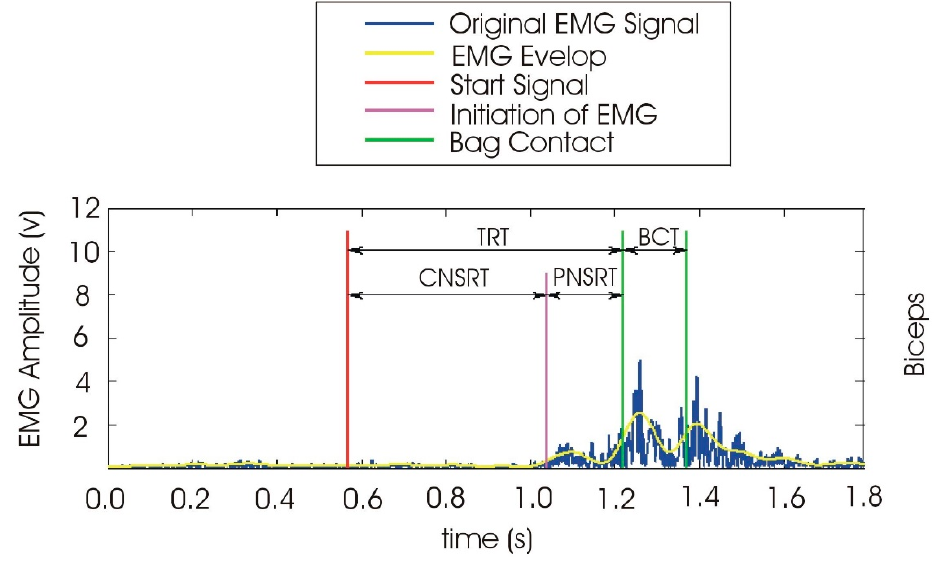
Figure 2. Quantification mechanism of the reaction time using the synchronized data collection and EMG enveloping method [24]. TRT: total reaction time, CNSRT: central nervous system response time, PNSRT—peripheral nervous system response time, BCT: bag contact time.